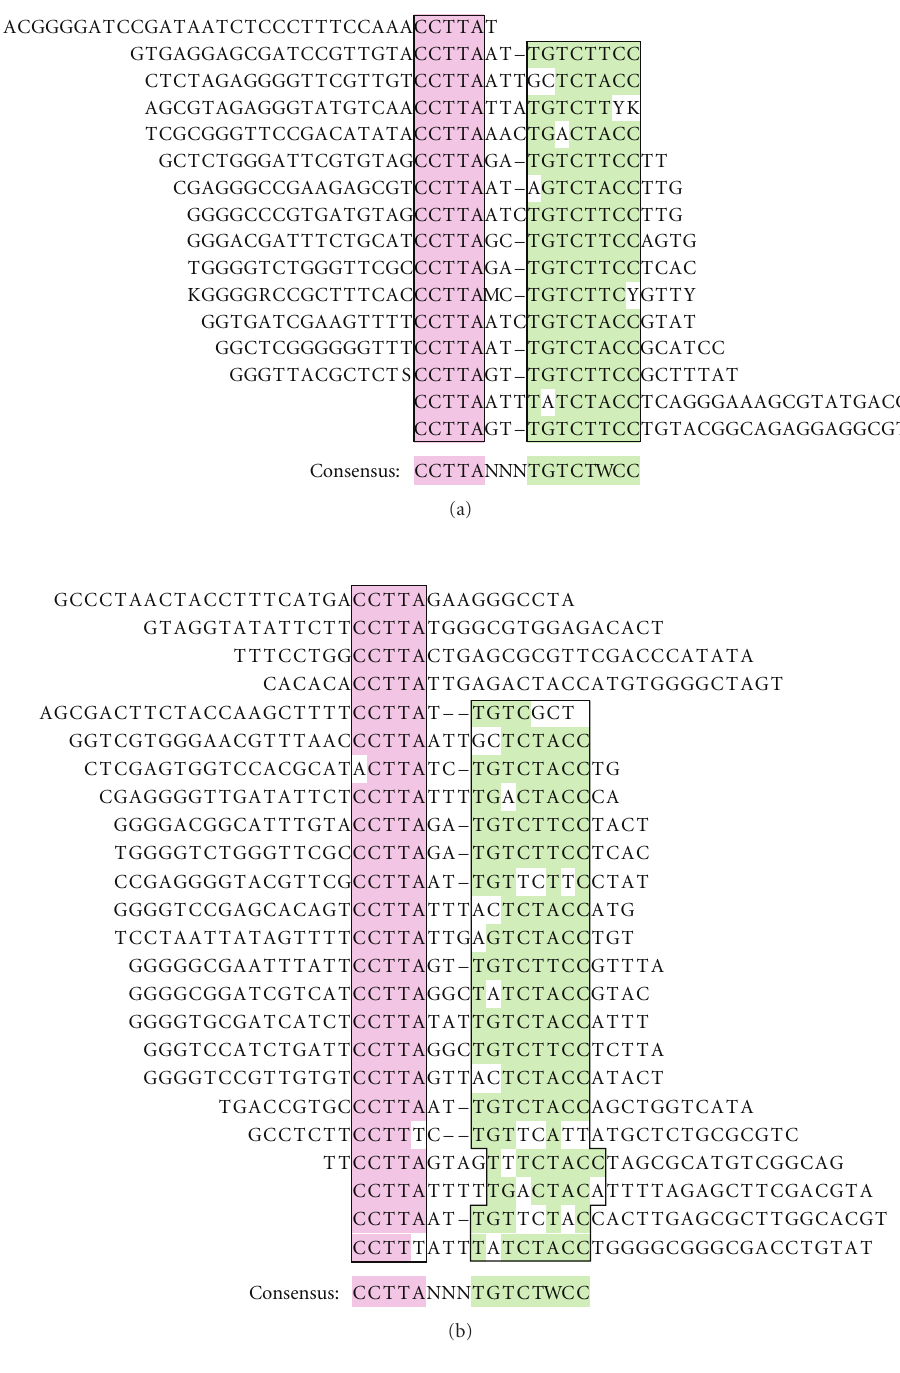
Figure 1: SELEX with or without the Flag-Stn1 protein yields the same bipartite consensus. A randomized pool of ssDNA molecules was incubated with an in vitro translation system programmed with either a Flag-Stn1 plasmid (Flag-Stn1 present) or water (Flag-Stn1 absent), after which protein/DNA complexes were recovered by immunoprecipitation using the anti-Flag M2 antibody. After six successive rounds of selection, the remaining oligonucleotides were cloned and sequenced. (a) Oligonucleotides selected in the presence of the Flag-Stn1 protein. The selected ssDNA molecules share a common bipartite consensus, which consists of a CCTTA (pink) and TGTCTWCC (green) motifs. Nonnucleotide letters denote ambiguous sequencing reads (R = A/G, Y = C/T, S = C/G, W = A/T, K = T/G, M = A/C). (b) Oligonucleotides selected in the absence of the Flag-Stn1 protein. The same bipartite consensus is shared among the ssDNA molecules selected by the mock- programmed in vitro translation